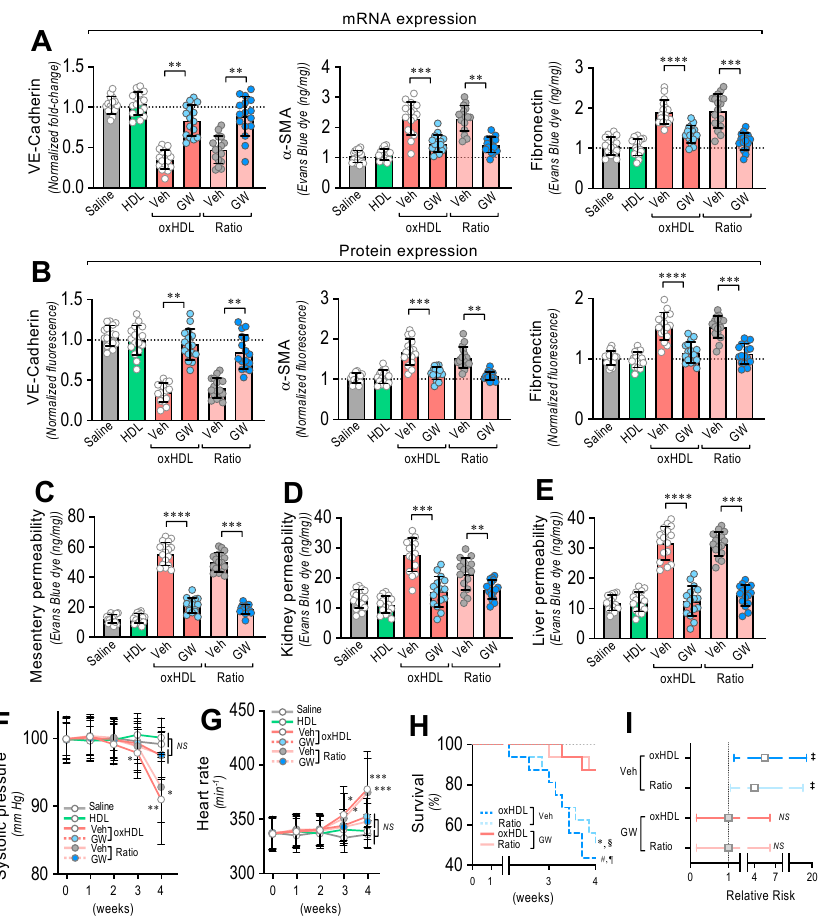
Figure 6. In vivo oxHDL administration induces endothelial fibrosis in rats inhibited by GW-788388. ( A ) After saline, HDL, oxHDL, and oxHDL/HDL ratio treatments, in the presence or absence of GW- 788388 administered by gavage (5 mg/kg a day) 1 week before and during the treatment, RMAECs were extracted and subjected immediately to determination of mRNA ( A ) and protein ( B ) expression of VE-cadherin (left panels), α -SMA (middle panels), and FN (right panels). (N = 16). ( C – E ) After saline, HDL, oxHDL, and oxHDL/HDL ratio treatments, in the presence or absence of GW-788388 administered by gavage (5 mg/kg a day) 1 week before and during the treatment, mesentery ( C ), kidney ( D ), and liver ( E ) were harvested and processed for EBD extraction to determine blood vessel hyperpermeability. EBD content was normalized to total sample weight (N = 16). ( F , G ) Systolic pressure ( F ) and heart rate ( G ) recording in saline, HDL, oxHDL, and oxHDL/HDL ratio treatments, in the presence or absence of GW-788388 administered by gavage (5 mg/kg a day) 1 week before and during the treatment at 1, 2, 3, and 4 weeks. (N = 16). ( H , I ). ( H ) Survival (Kaplan–Meier) curves comparing oxHDL and oxHDL/HDL ratio treatments, in the presence or absence of GW-788388 administered by gavage (5 mg/kg a day) 1 week before and during the treatment. * and #, p = 0.0003 (log-rank (Mantel–Cox) test) when comparing oxHDL- and oxHDL/HDL ratio-treated rats in the presence of GW versus oxHDL- (*) and oxHDL/HDL ratio-treated (#) rats in the absence of GW. § and ¶, p = 0.001 (Gehan–Breslow–Wilcoxon test) when comparing oxHDL- and oxHDL/HDL ratio-treated rats in the presence of GW versus oxHDL- (¶) and oxHDL/HDL ratio-treated (§) rats in the absence of GW. (N = 16). ( I ) Contingency analyses performed to determine relative risk between oxHDL- and oxHDL/HDL ratio-treated rats in the absence or presence GW. ‡, p = 0.03 (Fisher’s exact test) compared to saline-treated rats (N = 16). Statistical differences were assessed by one-way analysis of variance (ANOVA) (Kruskal–Wallis) followed by Dunn’s post hoc test and by two-way ANOVA followed by Dunnett’s post hoc test for ( F , G ). *, p < 0.05; **, p < 0.01; ***, p < 0.001; ****, p < 0.0001. Results are expressed as the mean ±